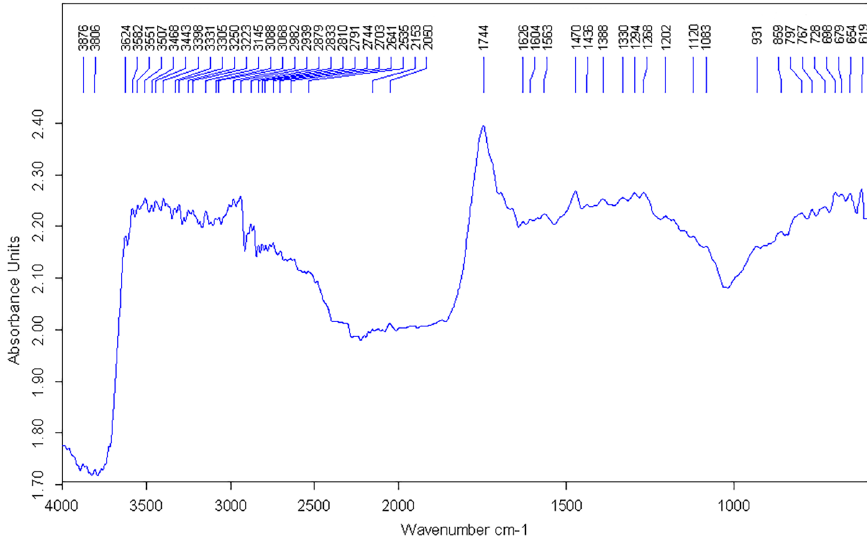
µ –FTIR spectrum of the varnish Figure 11. μ – FTIR spectrum of the varnish sample. Figure 11.